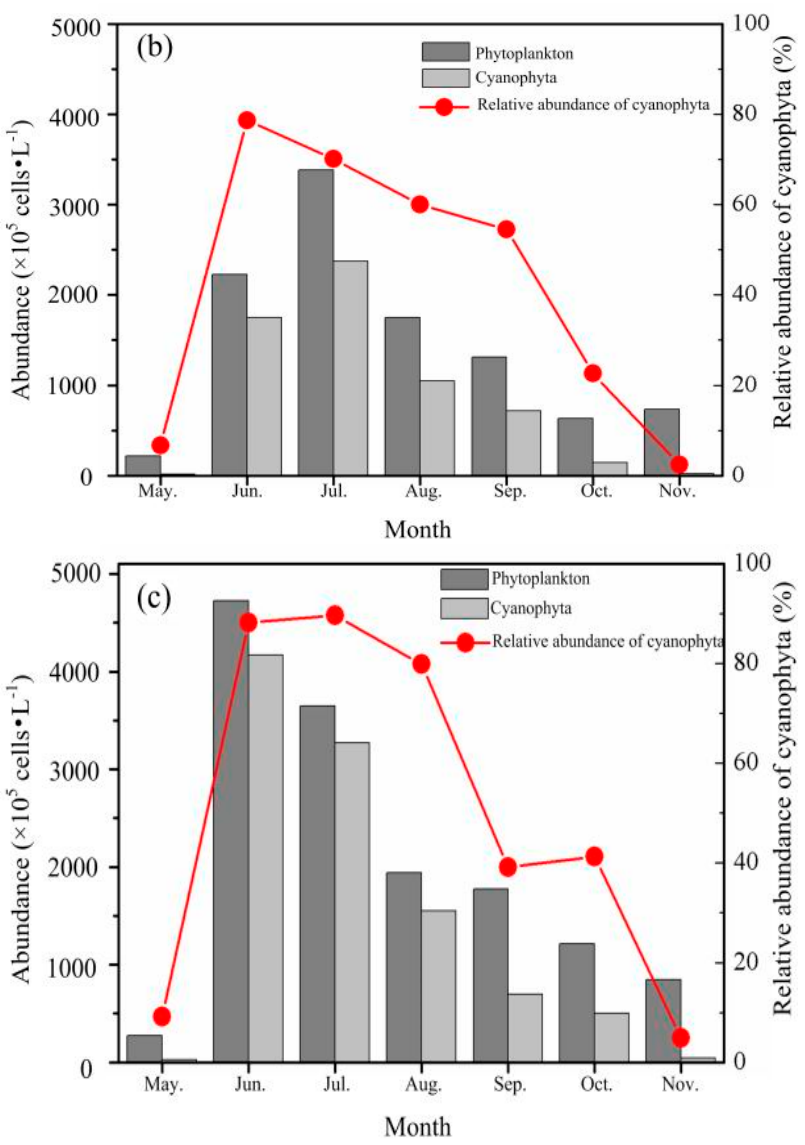
Figure 5. Spatial and temporal variations of phytoplankton and Cyanophyta abundance in upper, middle and lower reaches of the stream: ( a ) Upper reaches; ( b ) Middle reaches; ( c ) Lower reaches. Temporally, phytoplankton levels were low in spring (May), though they grew rapidly during early summer, reaching a maximum within 1–2 months. This is likely mainly due to increase in WT (Figure 2j), as well as a concurrent increase in daylight. Average phytoplankton levels in June and July were 1.78 × 10 8 , 2.80 × 10 8 , and 4.18 × 10 8 cells·L − 1 in upstream, middle, and lower reaches, respectively. Cyanobacteria was during summer the main phyla, comprising on average 54.2%, 74.5%, and 88.9% of the total phytoplankton in the three sections, respectively, through the summer and fall algae bloom decreased gradually. With a drop in WT from 29 °C in August to 18 °C in November, the relative contribution of Cyanophyta to total phytoplankton abundance decreased by between 94% to 96%. It appears thus clear that the decrease in WT and daylight especially inhibited the growth of Cyanophyta relative to the other phytoplankton groups.